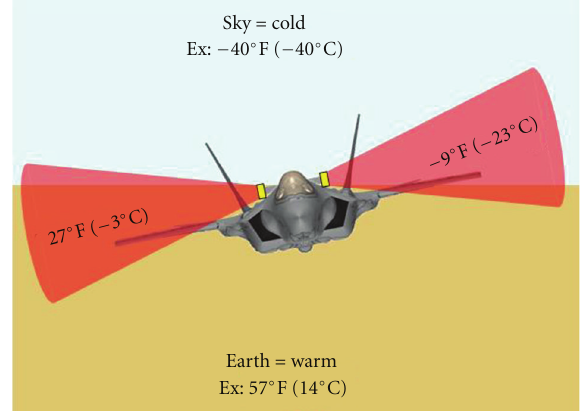
Figure 23: Example of angle compensation using two IR sensors reproduced from [64] under GNU FDL 1.2.